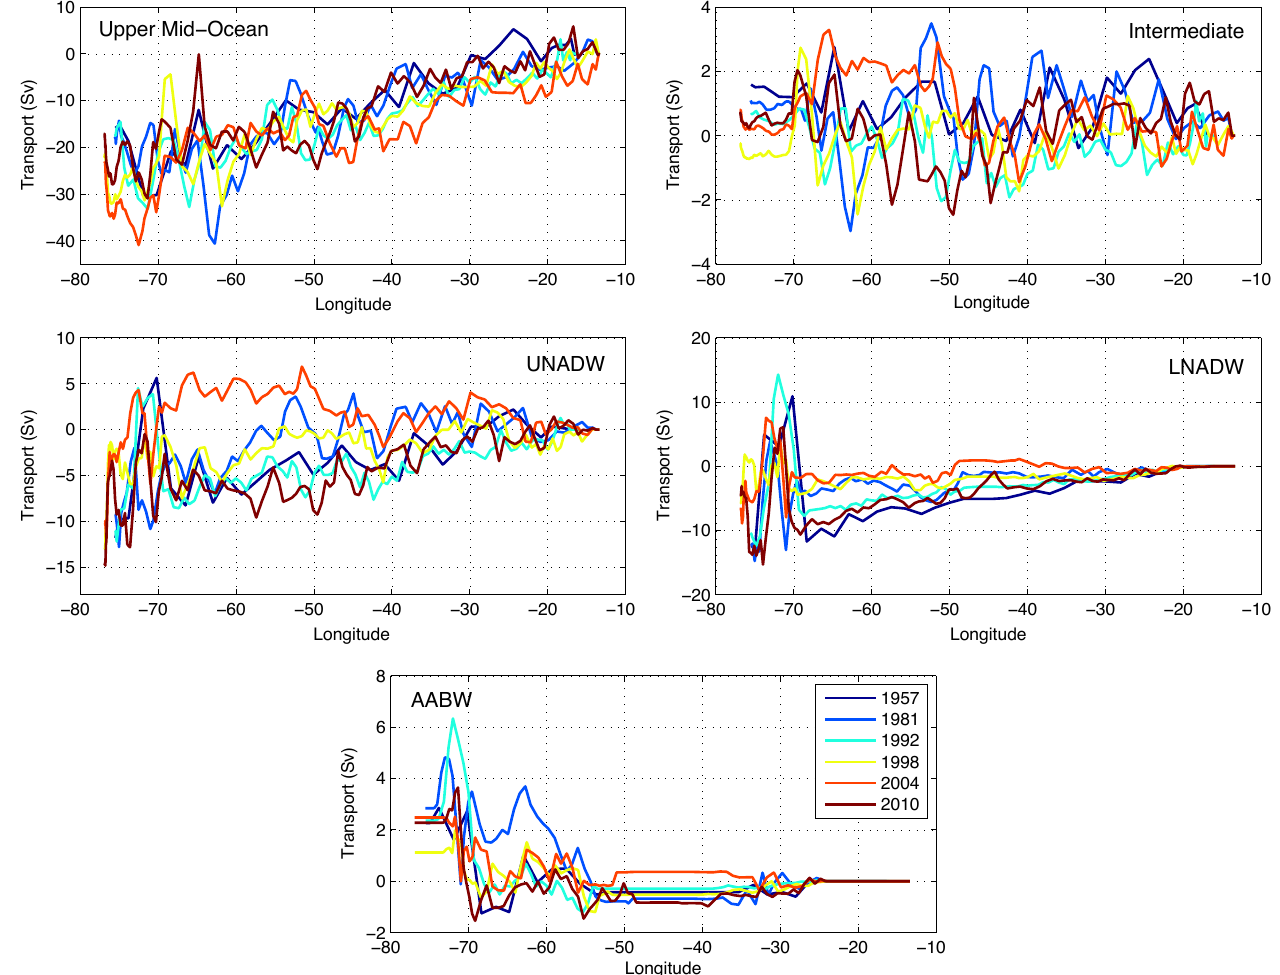
Fig. 9. Cumulative mid-ocean transport summed from east to west for the 1957, 1981, 1992, 1998, 2004 and 2010 hydrographic sections (following Longworth, 2007). Depth intervals are given in Table